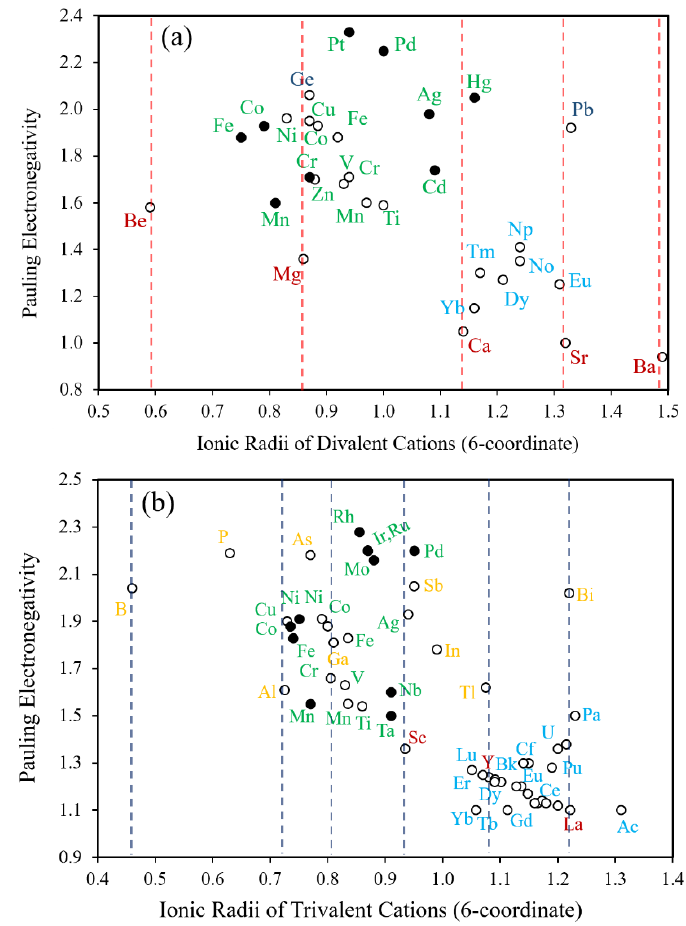
Figure 22. Plots of the crystal radii versus Pauling electronegativity of ( a ) divalent and ( b ) trivalent TM and RE cations, where the low-spin and down-spin cations are represented by shaded and unshaded circles, respectively.